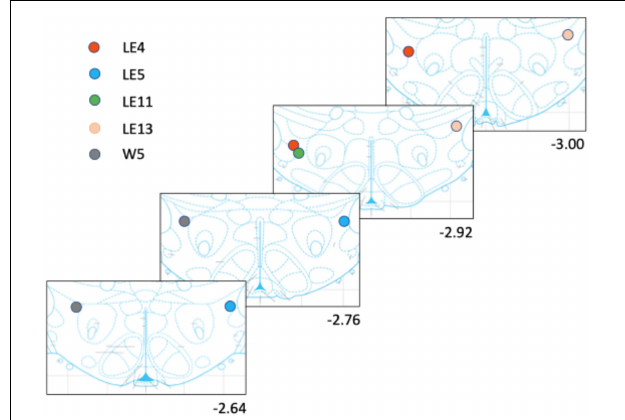
Loc = Value of the location parameter (it refers to the placement of the curve within the stimulation range, and together with TA 50 informs about rightward or leftward shifts), TA = Time allocation, TAmin = Minimal time allocation, TAmax = Maximal time allocation, and Slp = Slope parameter determining the steepness of the rise (Trujillo-Pisanty et al., 2020; Pallikaras et al., 2021). PRISM (v9, GraphPad Software, San Diego, CA, United States) was used to fit functions, statistical analysis, and produce data